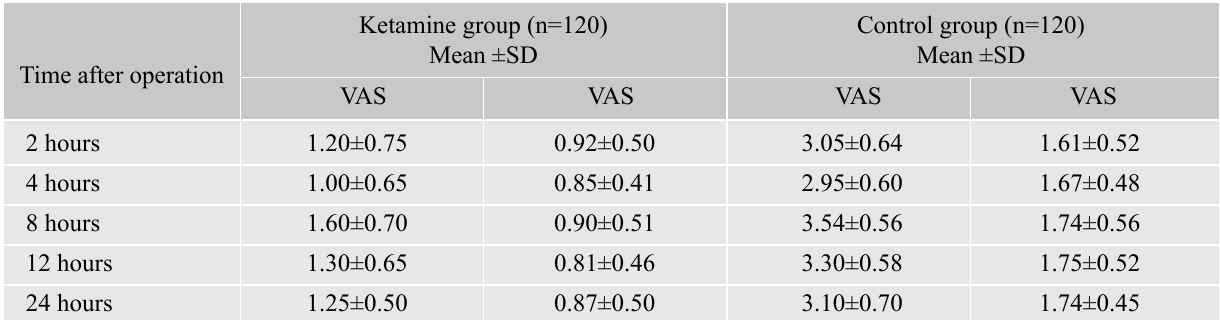
Table III: Visual Analogue Scale (VAS) and Verbal Rating Score (VRS) of patients at different times